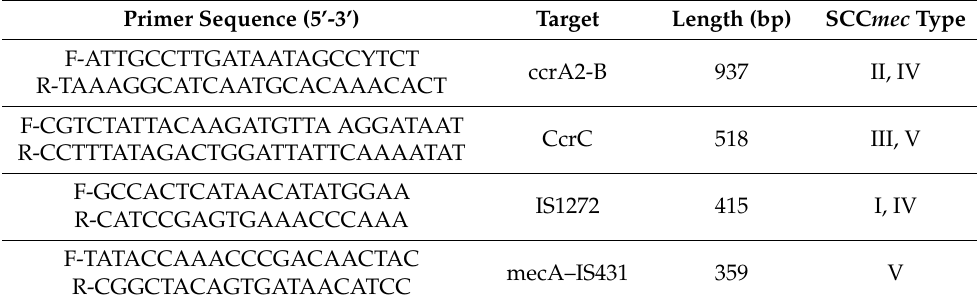
Table 2. Primers used in the multiplex SCC mec PCR.